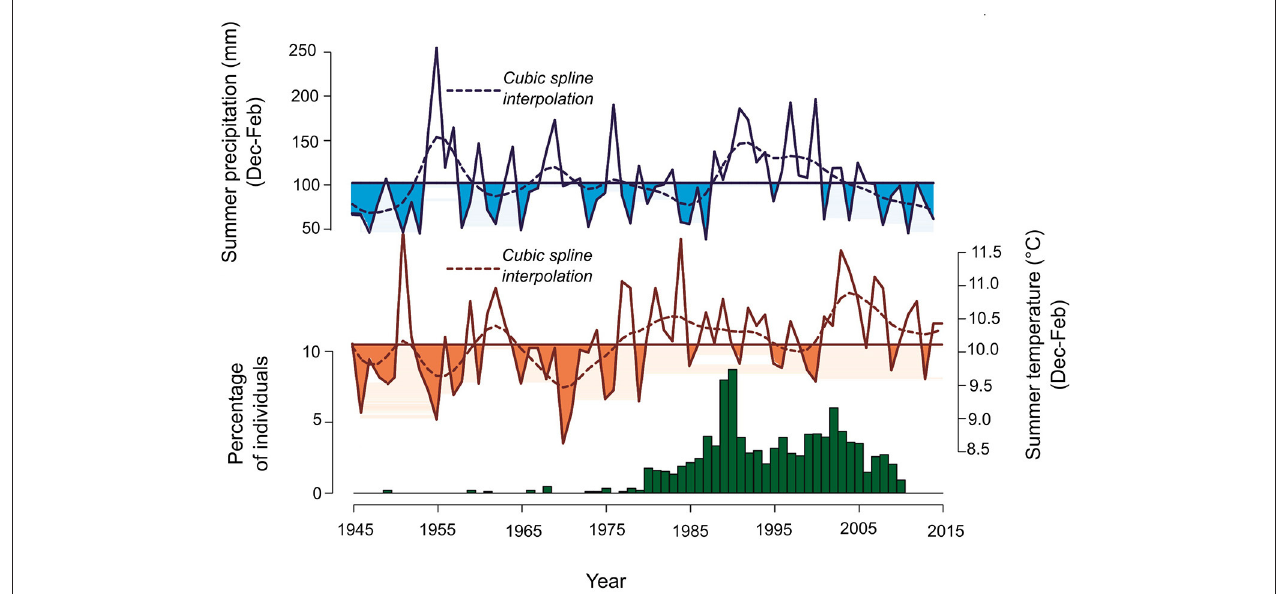
FIGURE 5 | Temporal variations in regional seedling establishment at the upper treelines in southern Patagonia and in Punta Arenas summer (December to February) temperature and precipitation. Straight lines represent the summer temperature and precipitation means. Smoothed versions of establishment and climatic variations using a cubic spline function of 10 years are also shown (dashed